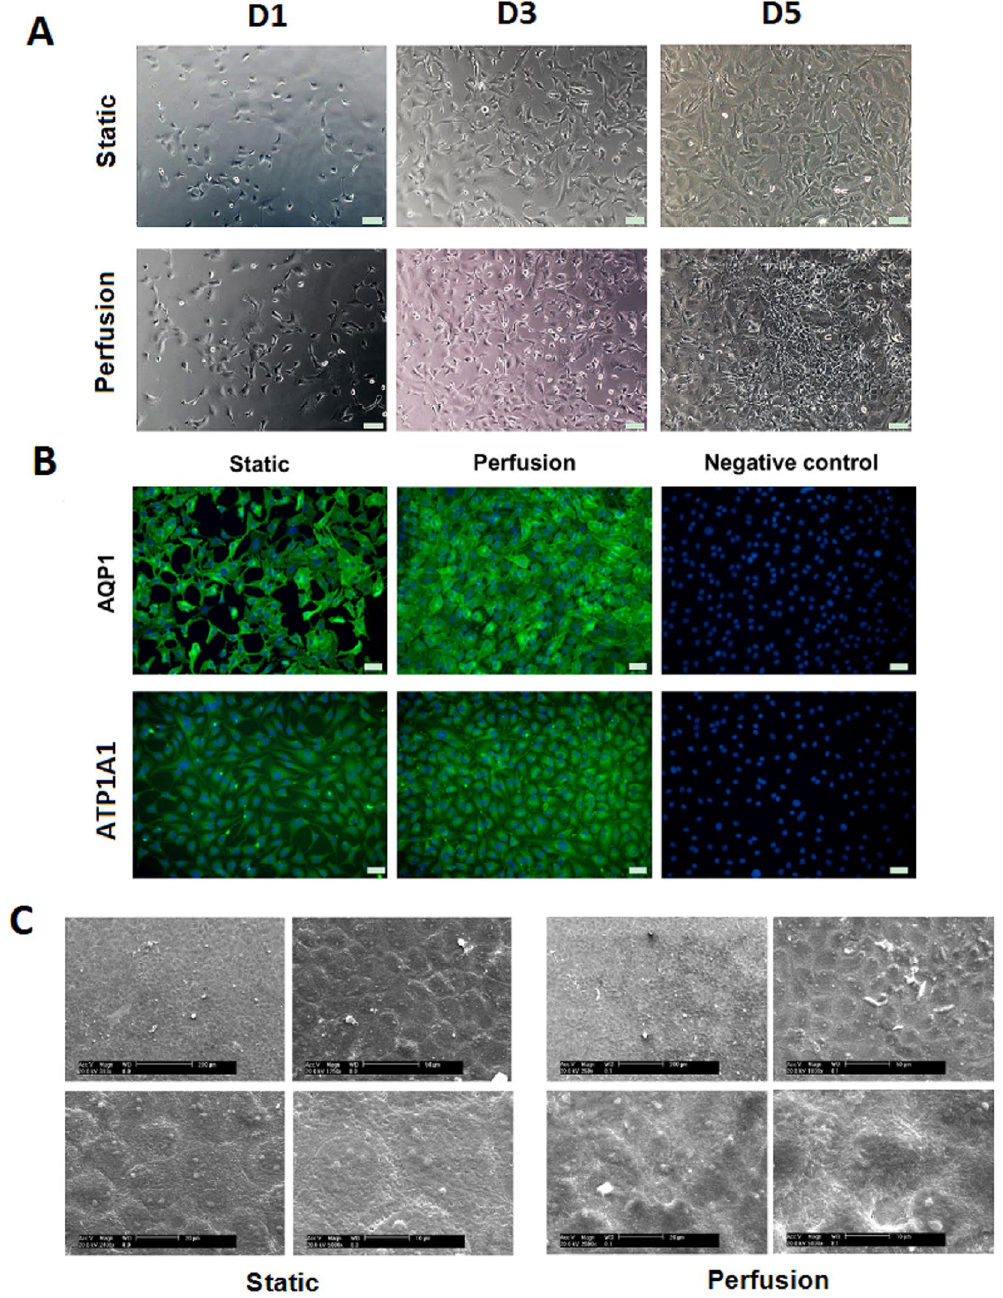
Figure 3. Maintenance of the CEC phenotype in the perfusion system. ( A ) Representative phase- contrast images of CECs in the static and perfusion systems at D1, D3 and D5. Scale bar: 100 μ m. ( B ) Immunofluorescence images of AQP1 and ATP1A1 staining. Scale bar: 50 μ m. ( C ) SEM images of CECs on glass carriers in the static and perfusion